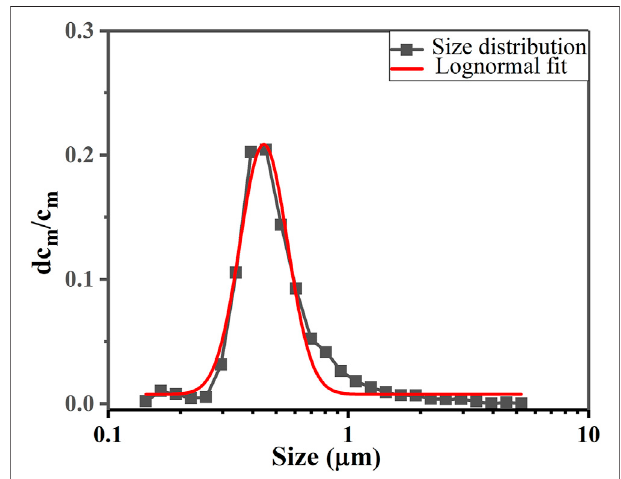
FIGURE 3 | Aerosol size distribution of TiO 2 with mass median diameter 0.50 μ m.